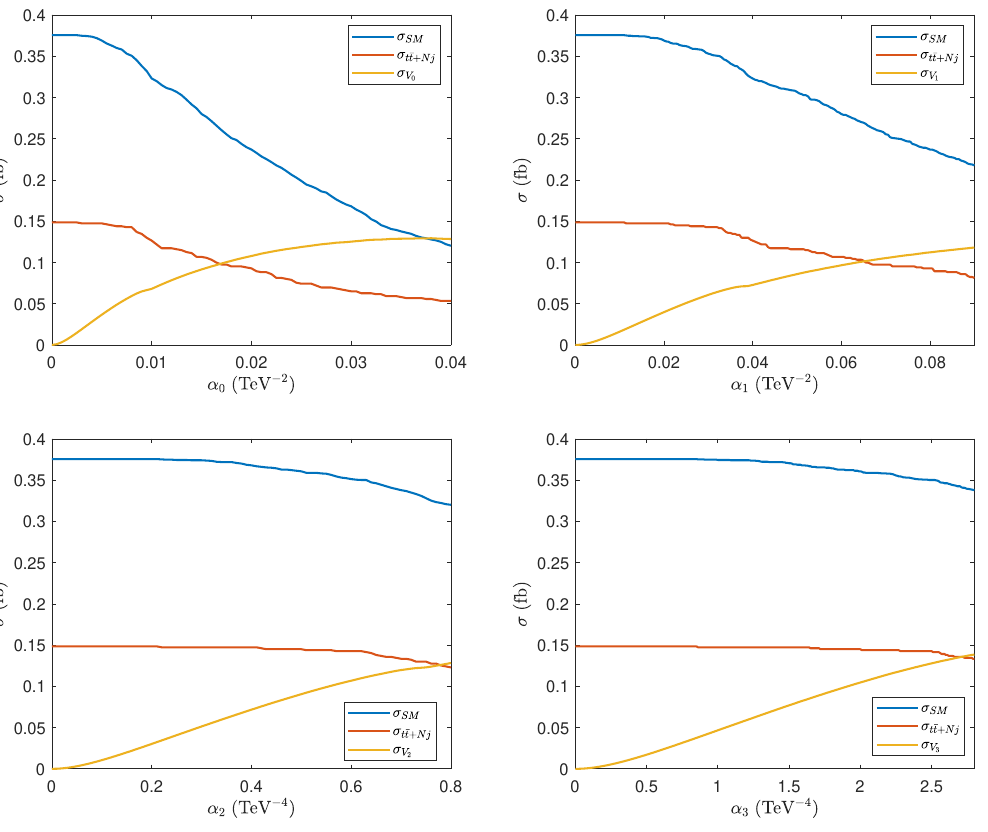
Figure 14 . The cross-sections as functions of the coefficients of aQGCs after the cuts listed in table 2 and after the unitarity